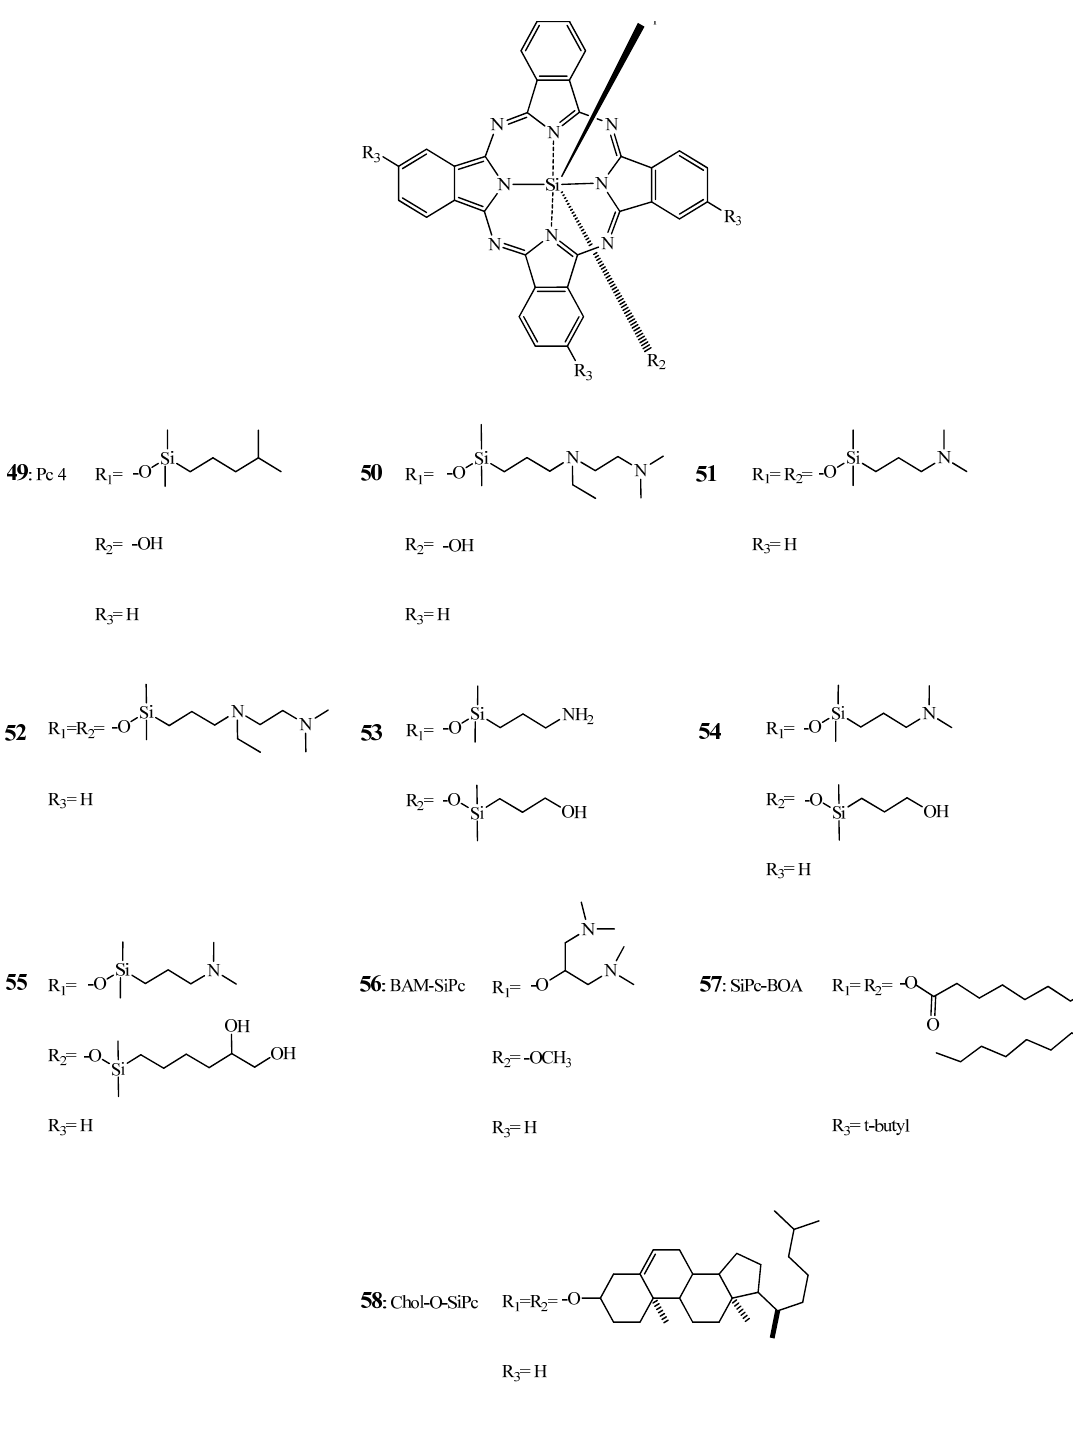
Figure 17. Chemical structure of Pc 4 ( 49 ) and derivatives 50–58